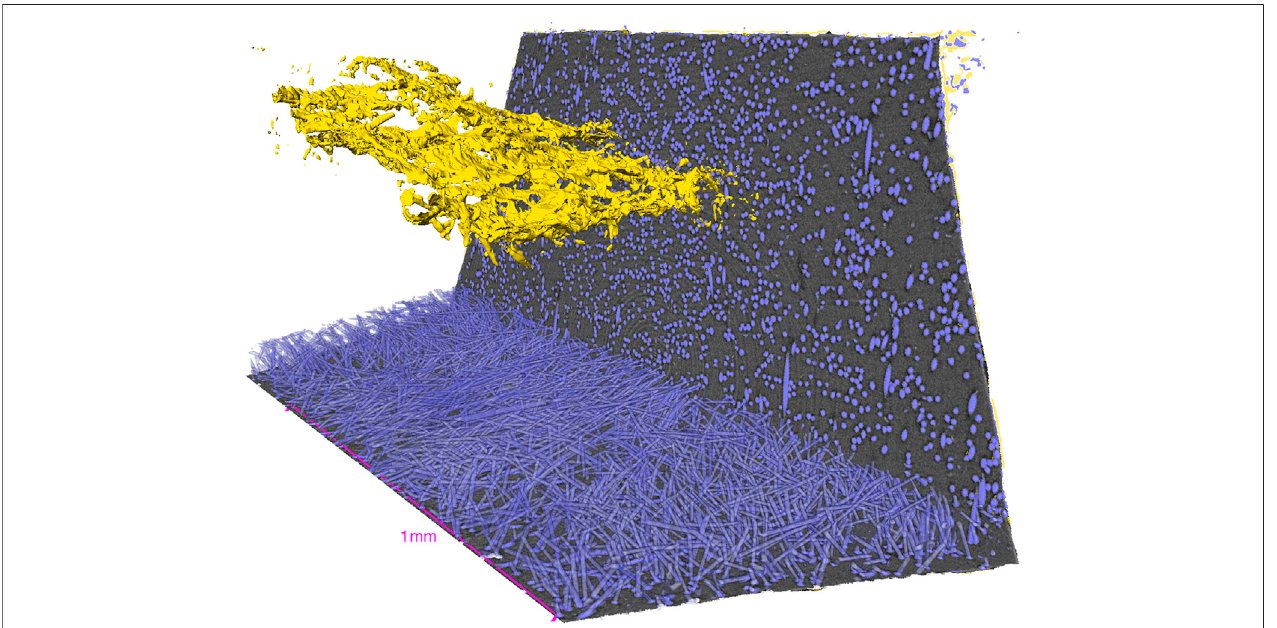
FIGURE 5 | Segmentation generated by the 2D model on the volume Crack. Image rendered with standard tools in Avizo for the sake of visualization: two orthogonal planes inside the specimen, fi bers rendered in 3D at the bottom, and the fracture rendered as a surface. Phase color code: blue represents the fi ber and yellow represents the porosity.